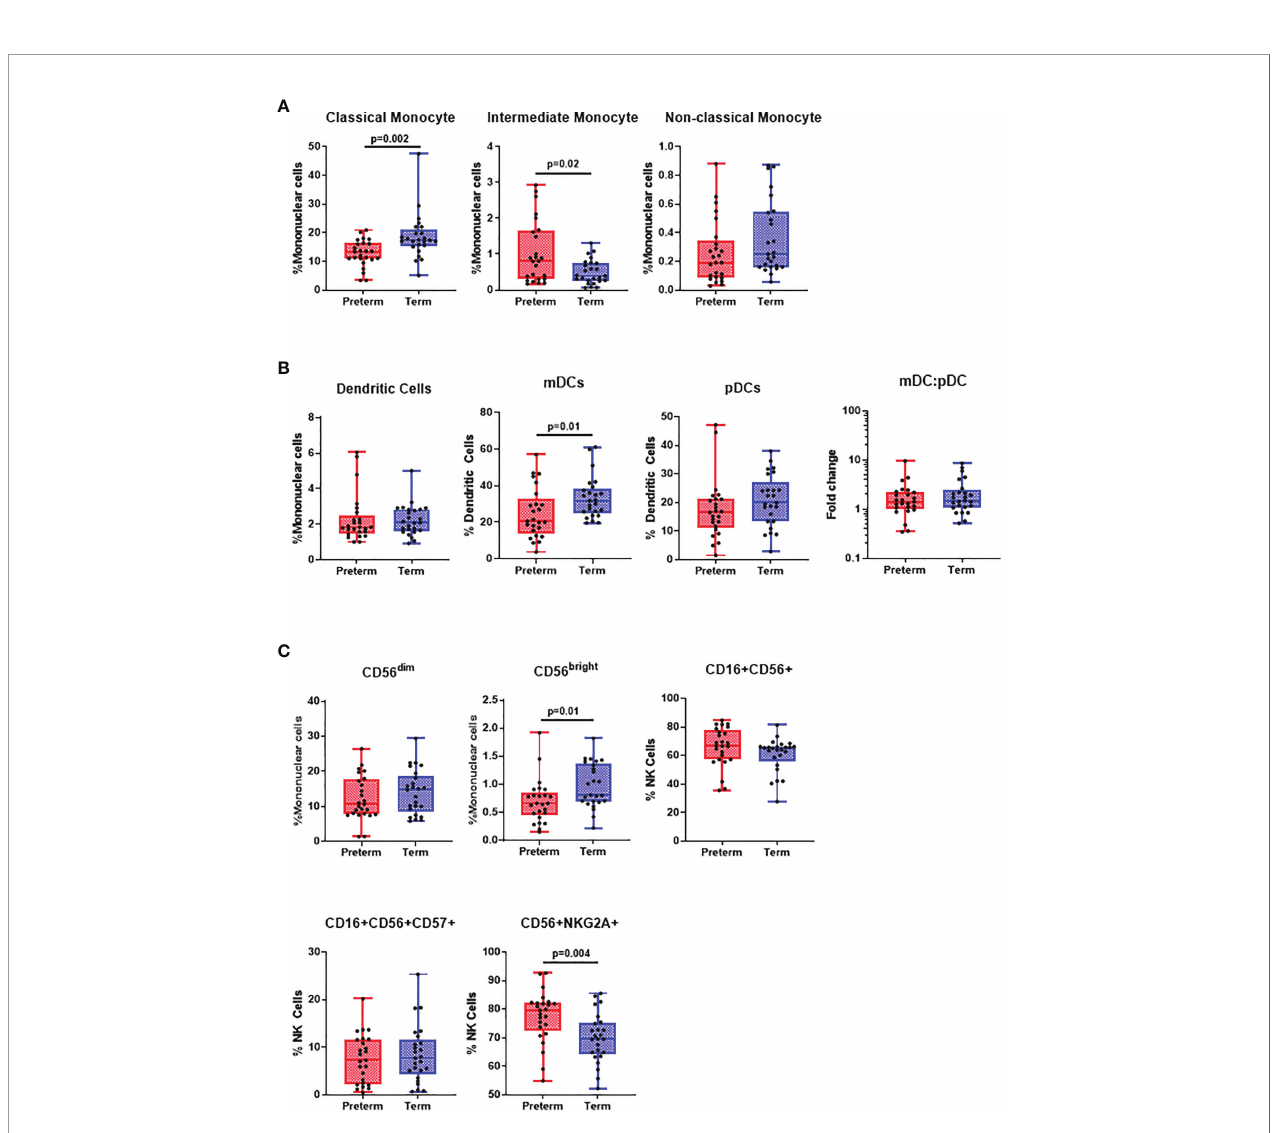
FIGURE 1 | Differences in innate cell populations in preterm and term infants . Flow cytometry was performed on cord blood mononuclear cells from 25 preterm and 25 term infants. (A) Classical monocytes, intermediate monocytes and non-classical monocytes were expressed as % of mononuclear cells. All data was presented as a median +/- interquartile range (IQR) with min-max whiskers. (B) Dendritic cells were expressed as % of mononuclear cells, while myeloid and plasmacytoid dendritic cells were expressed as % of dendritic cells. (C) CD56 dim and CD56 bright NK cells were expressed as % of mononuclear cells whilst CD16+, CD16+CD57+ and NKG2A+ NK cells were expressed as % of total NK cells. A Mann-Whitney U-test was performed for all analysis and a p<0.05 was considered signi fi